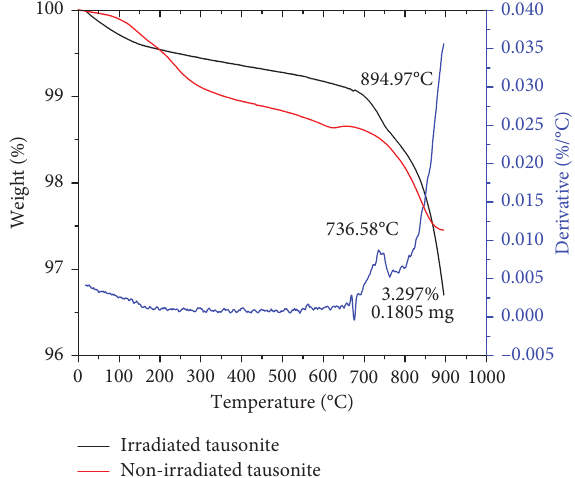
Figure 3: TGA/DSC analysis of irradiated and nonirradiated tausonite.